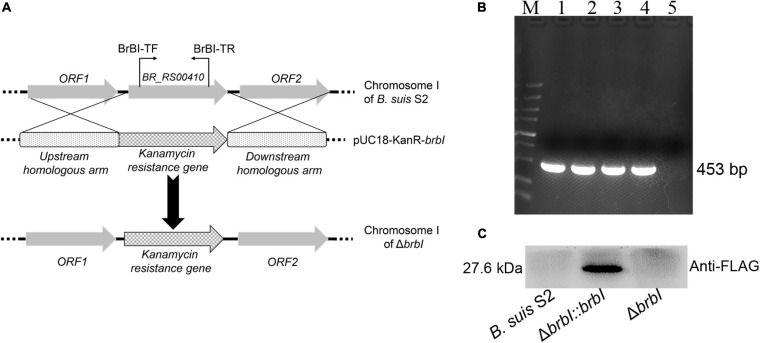
Verification of the ΔbrbI strain and its complemented strain. (A) Schematic of the ΔbrbI strain generation. (B) ΔbrbI strain verification via PCR using the BrBI-TF/TR primer pair. Lane 1 is the B. suis S2 strain; lanes 2–5 are ΔbrbI strain candidates. Lane 5 is the confirmed mutant strain. (C) The ΔbrbI::brbI strain was verified via WB using a mouse anti-FLAG monoclonal antibody.